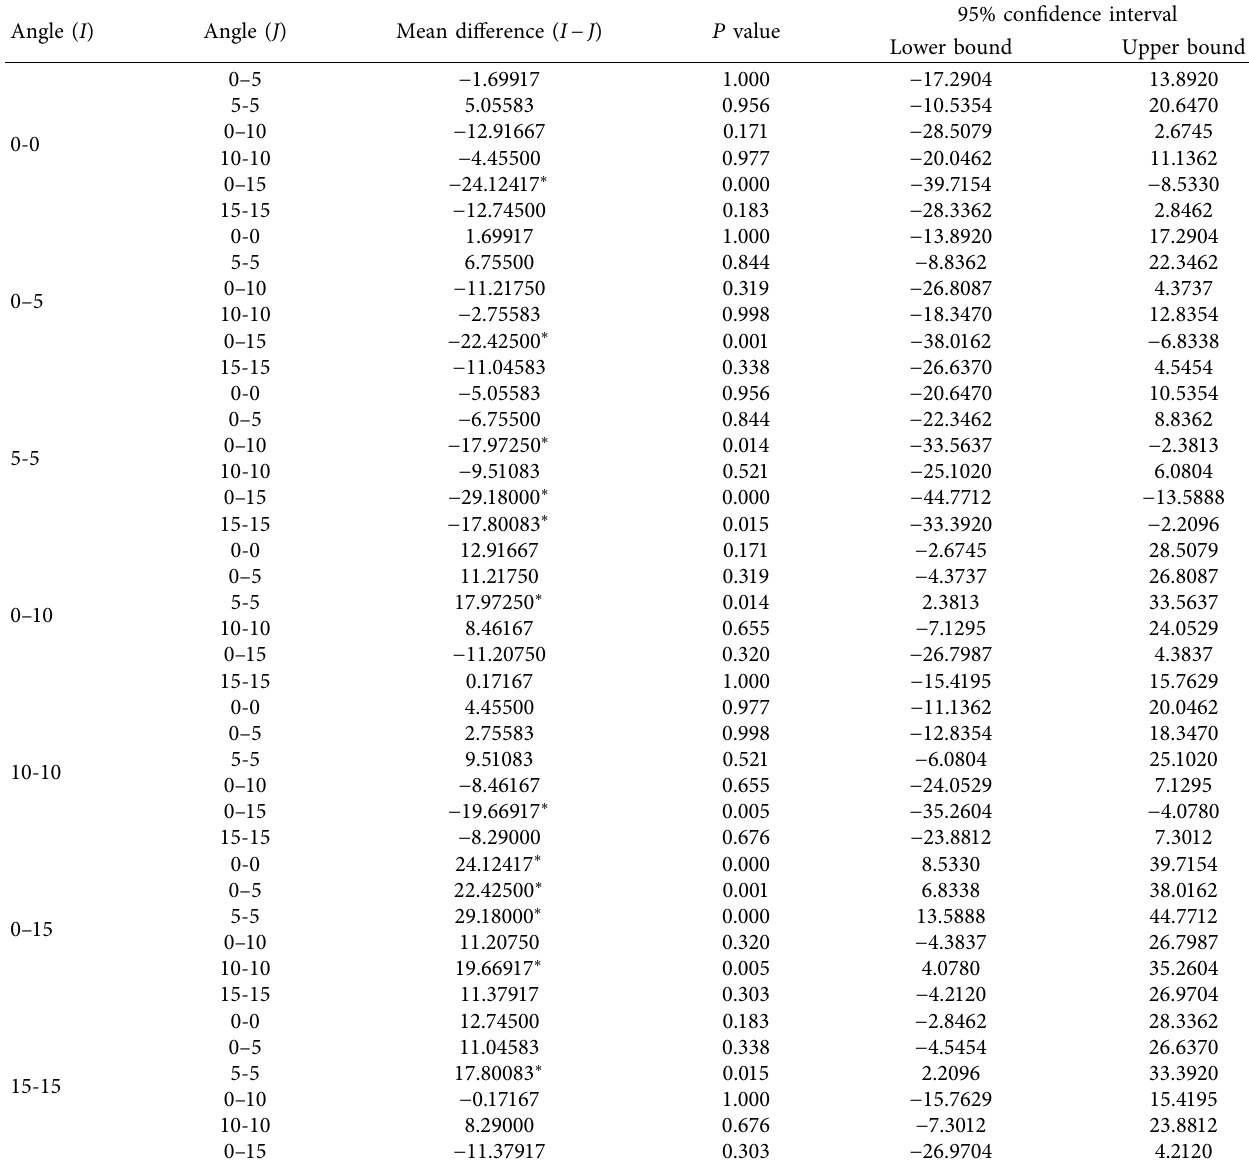
Table 6: Pairwise comparison of retentive strengths with different implant